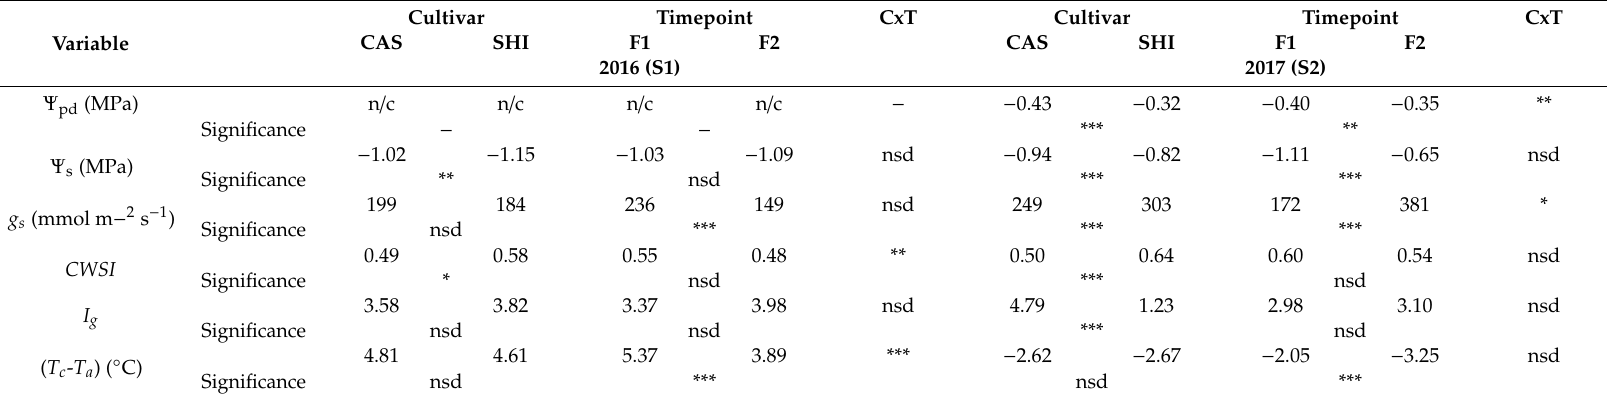
Table 2. Vine water status measures of CAS and SHI grapevines at v é raison (F1) and pre-harvest (F2) during the 2016 (S1) and 2017 (S2) seasons. Variable